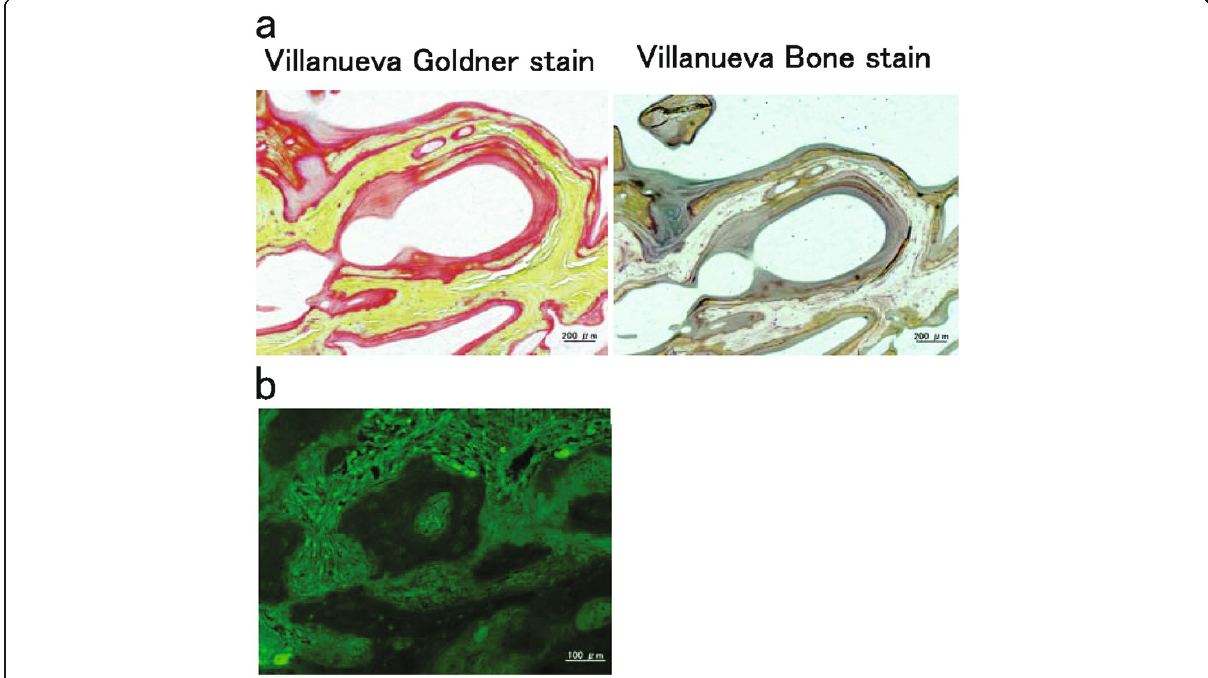
Figure 2 Pathological examinations. a : Mineralized bone tissues are colored in green and nonmineralized osteoid tissues are shown in orange by Villanueva-Goldner stain. Mineralized bone tissues are colored in purple and nonmineralized osteoid tissues are shown in the clear zone by Villanueva bone stain. The osteoids volume/mineralized bone volume ratio was 20.7% (normal range, less than 10%). Osteoid thickness was 25.1 μ m (average, less than 12.5 μ m). b : Tetracycline labeling examination showed no double-labeling pattern. These findings indicate mineralization deficiency and